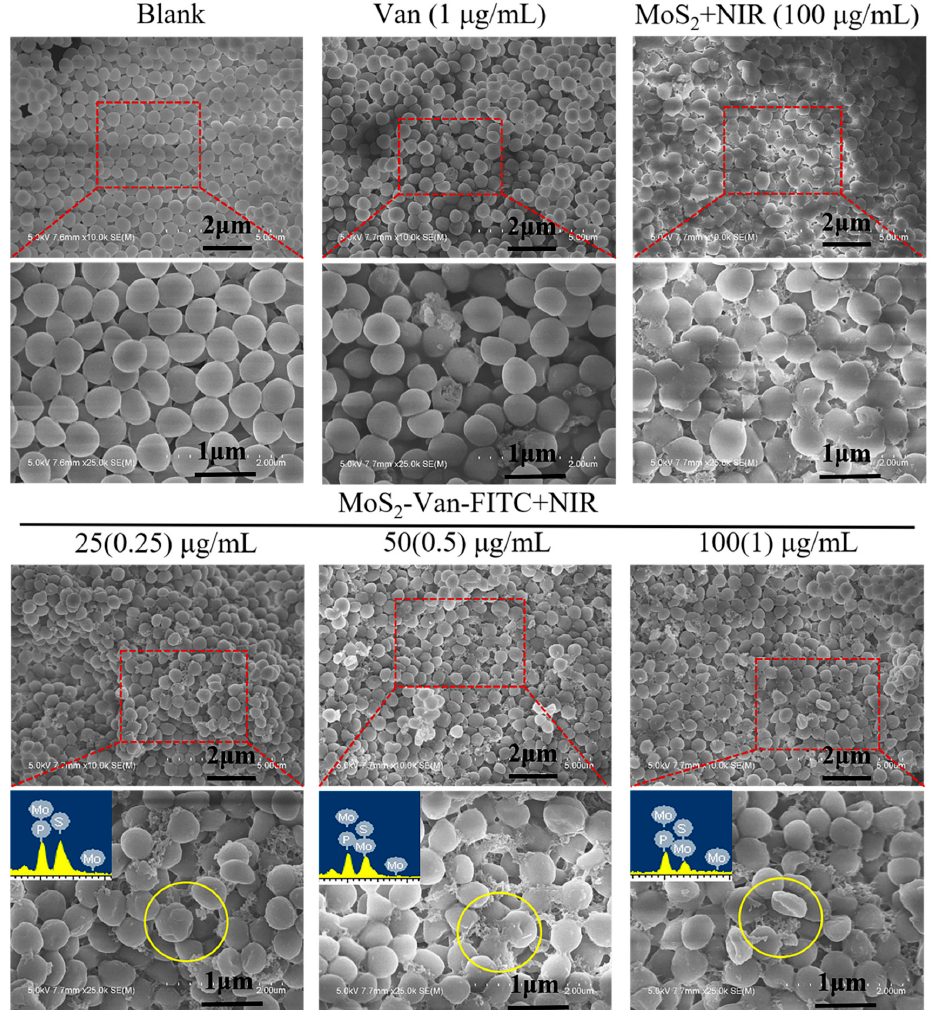
Figure 7. SEM images of S. aureus cells. The bacterial cultures were treated with MoS 2 -Van-FITC NPs at various concentrations (25, 50 and 100 µg/mL). The bacterial cultures treated with Van (1 µg/mL) and MoS 2 NPs + NIR (100 µg/mL) served as control groups. PBS + NIR served as a blank group. The red squares indicate the enlarged regions. The blue area is the elemental analysis chart. The cells underwent NIR irradiation at 808 nm (1.5 W/cm 2 , 6 min).